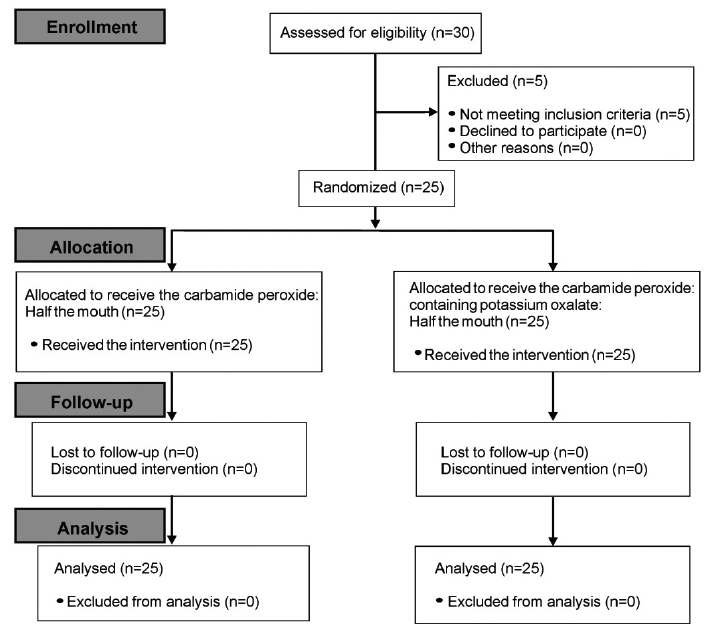
Figure 3- Flow-chart diagram of the volunteers selection detaching the enrollment, allocation, follow-up and analysis during the study (CONSORT